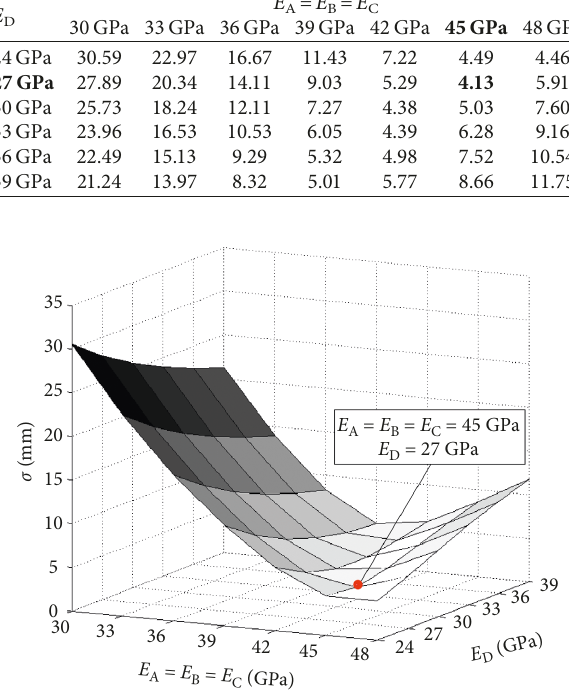
Figure 13: Three-dimensional graph of standard deviation of combined results of E A and E D .